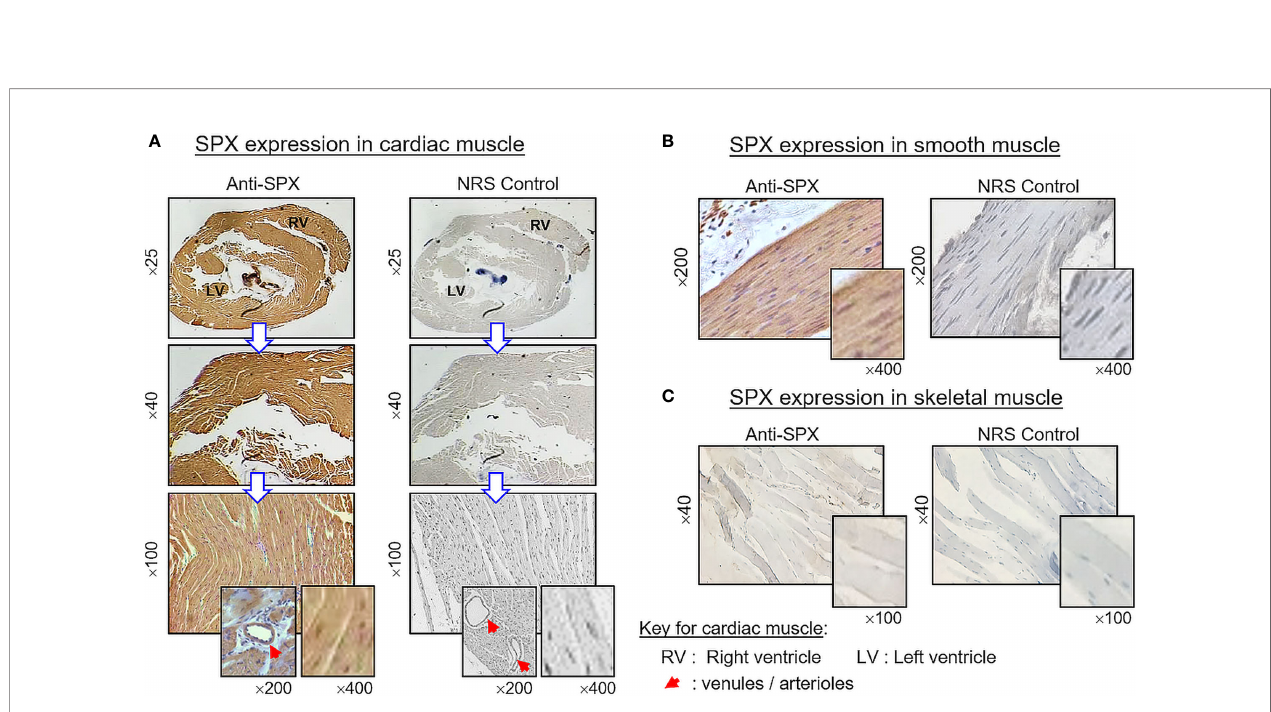
FIGURE 13 | Histological distribution of SPX expression in different muscle types. SPX expression in (A) cardiac muscle, (B) smooth muscle, and (C) skeletal muscle as revealed by IHS with anti-SPX. SPX immunoreactivity could be detected in cardiac muscle forming different parts of the heart (e.g., left/right ventricles) and smooth muscle forming the muscularis layers of GI tract. However, it was not apparent in the myo fi bers of skeletal muscle. Similar to other tissues, SPX signals were found in the endothelial cells and muscle layer of arterioles/venules within the cardiac muscle (insets). In this study, parallel staining with NRS was used as negative control and the numbers on the side (×25, ×40, ×200, and ×400) represent the magni fi cation of the respective